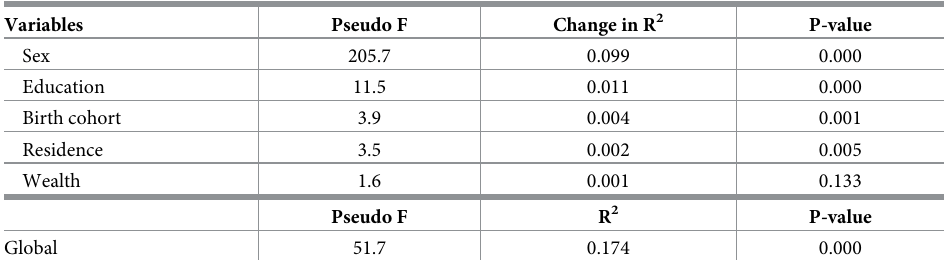
Table 3. Multifactor discrepancy analysis of reproductive trajectory,